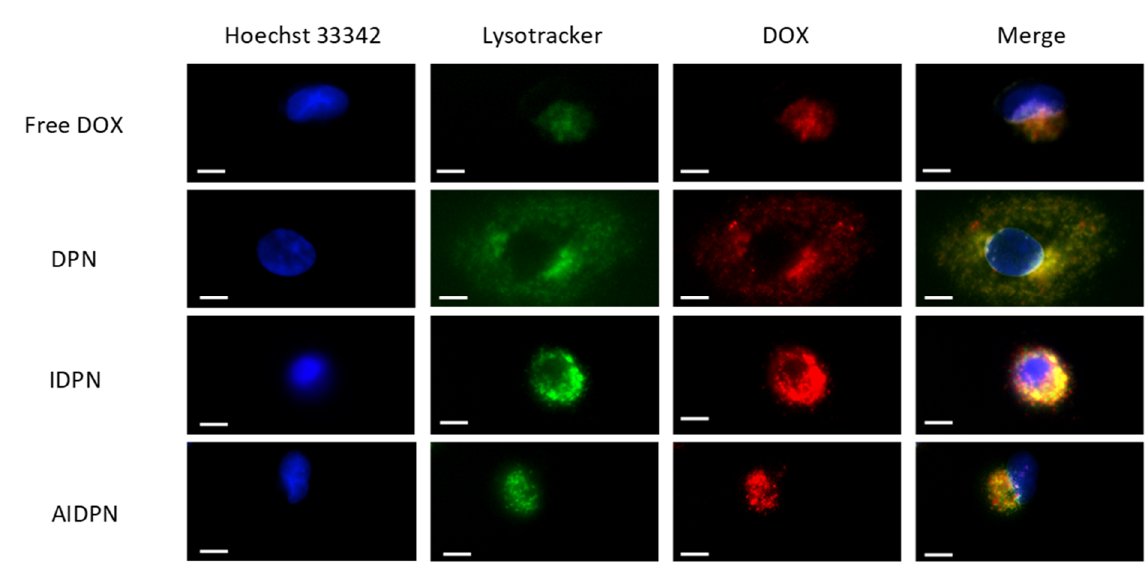
Figure 7. Fluorescence image of free DOX, DPN, IDPN, and AIDPN in A549. Blue represented nucleus (stained with Hoechst 33342); green represented endo/lysosomes (stained with Lysotracker); red was the DOX fluorescence. Scale bar 10 μm.